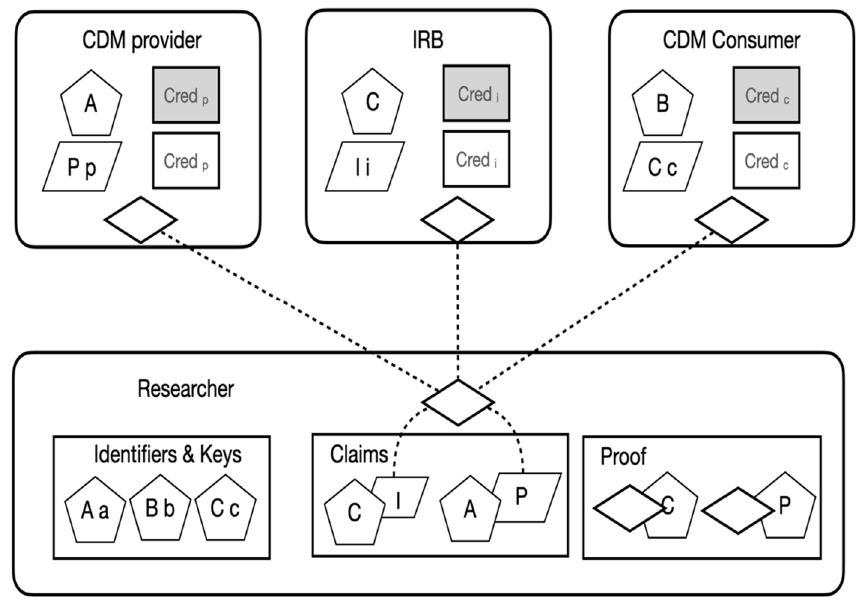
Figure 5. The capability based Identity Management in a cloud CDM.